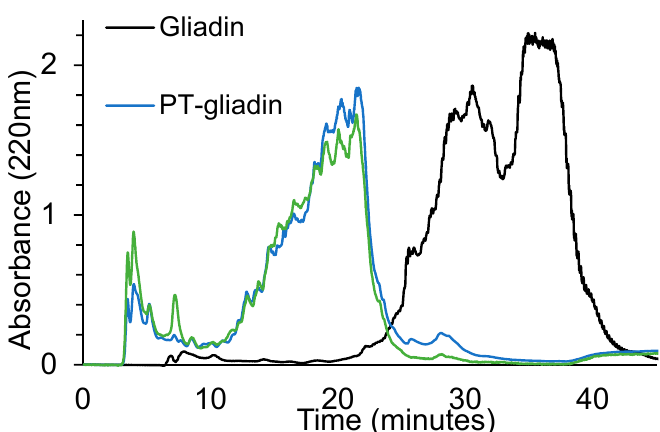
Figure 3. Reverse phase HPLC of Gliadin (black line), PT-Gliadin (blue line) and PT-gliadin + bact (green line).